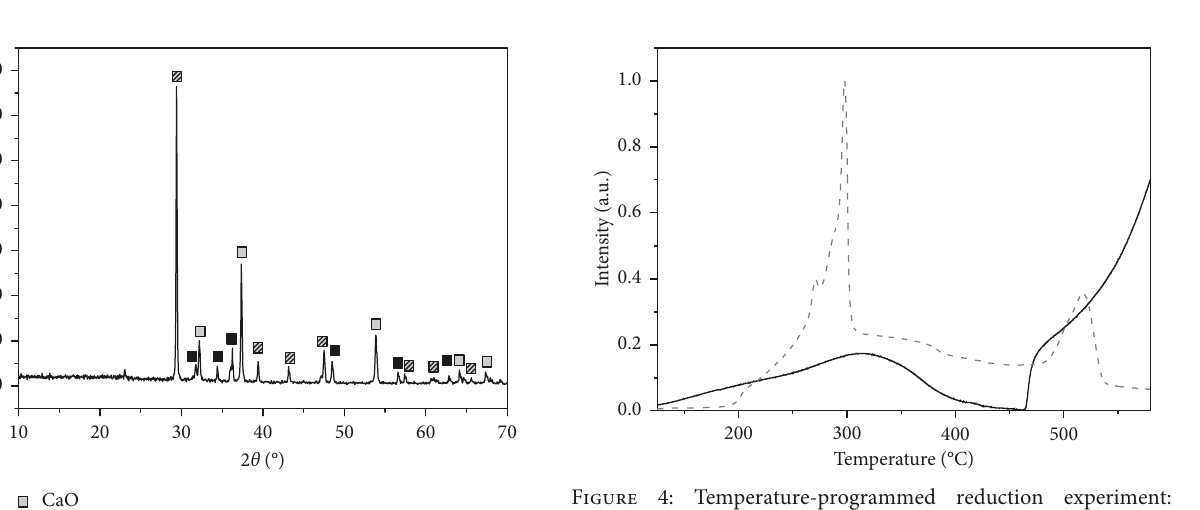
Figure 2: SEM images of the fresh catalyst.